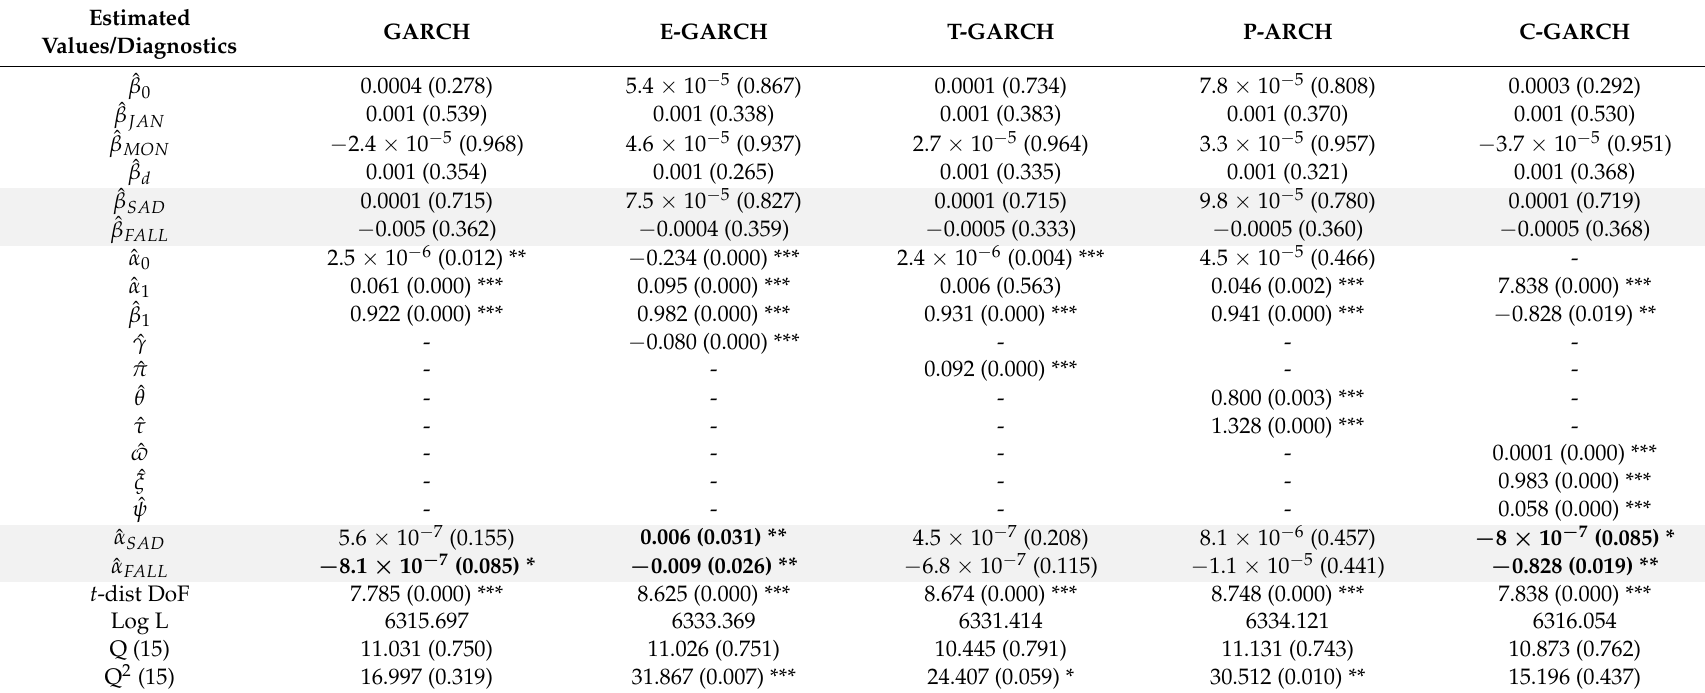
Table A4. Different GARCH specifications for